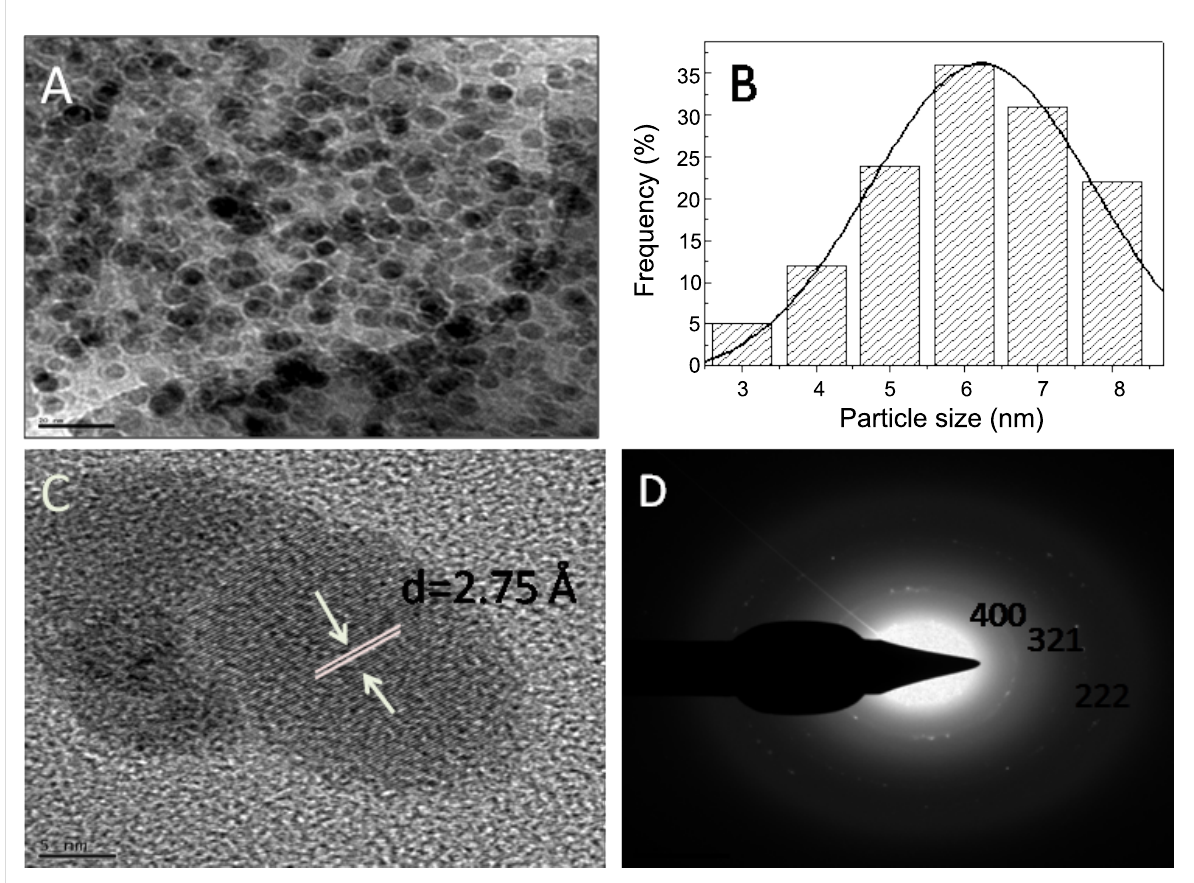
Figure 2: (A) TEM micrograph recorded from drop-cast films of Gd 2 O 3 nanoparticle solution formed by the reaction of GdCl 3 with the fungal biomass of Humicola sp. for 96 h. (B) Particle size distribution determined from TEM microgaph. (C) HR-TEM image of Gd 2 O 3 nanoparticles showing inter planar distance. (D) Selected area electron diffraction (SAED) pattern recorded from the Gd 2 O 3 nanoparticles.